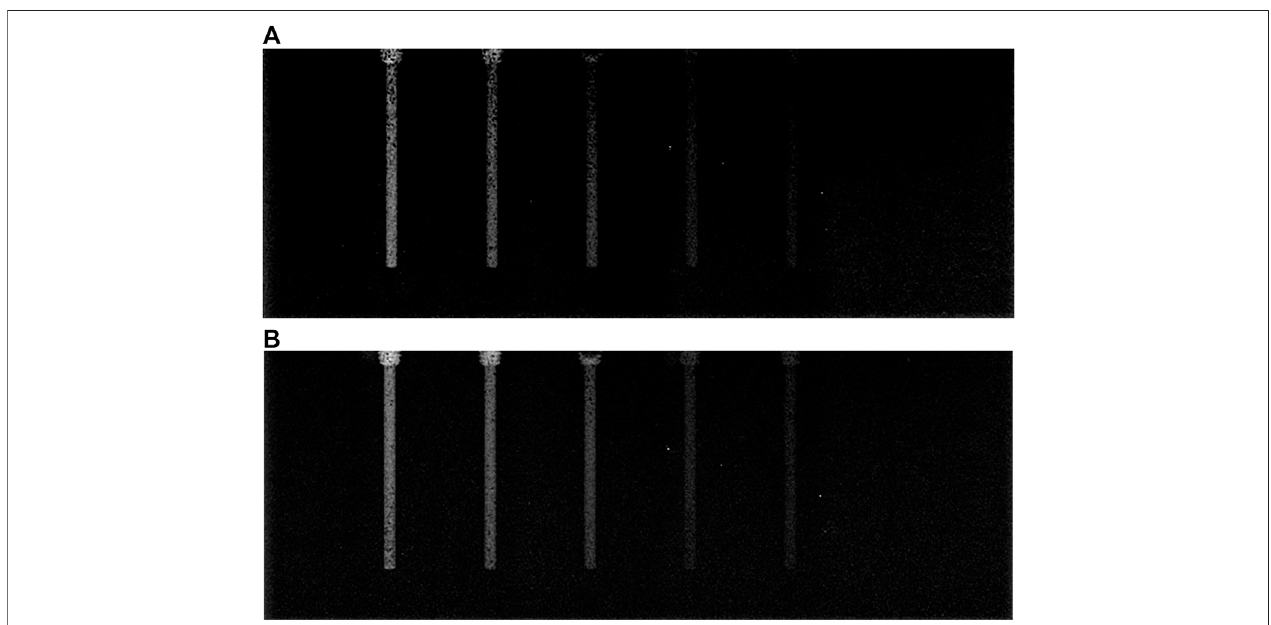
FIGURE 8 | Comparison of decomposition images obtained by TASM and GSSM: (A) decomposition image of TASM, (B) decomposition image of GSSM.